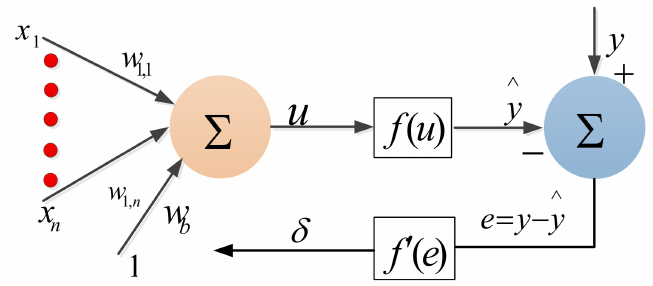
Figure 2. A Single neuron for back-propagation training MLP